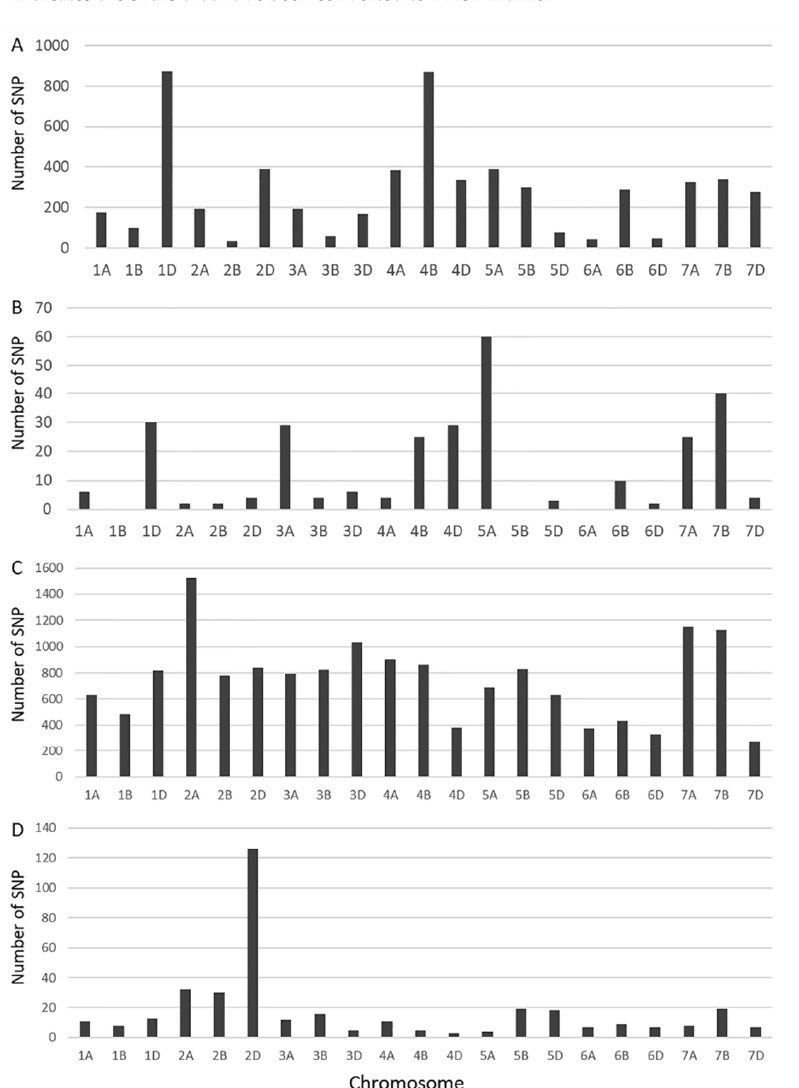
Figure 3. The distribution of polymorphic SNP sites identified by 55K_SNP array. ( A , C ) show the distribution of polymorphic SNP between Shannong 135 and Siyang 936, Huaimai and CD1840, respectively; ( B , D ) show the distribution of polymorphic SNP between the tolerant and sensitive bulks derived from Shannong 135 × Siyang 936 and Huaimai 18 × CD1840 populations,